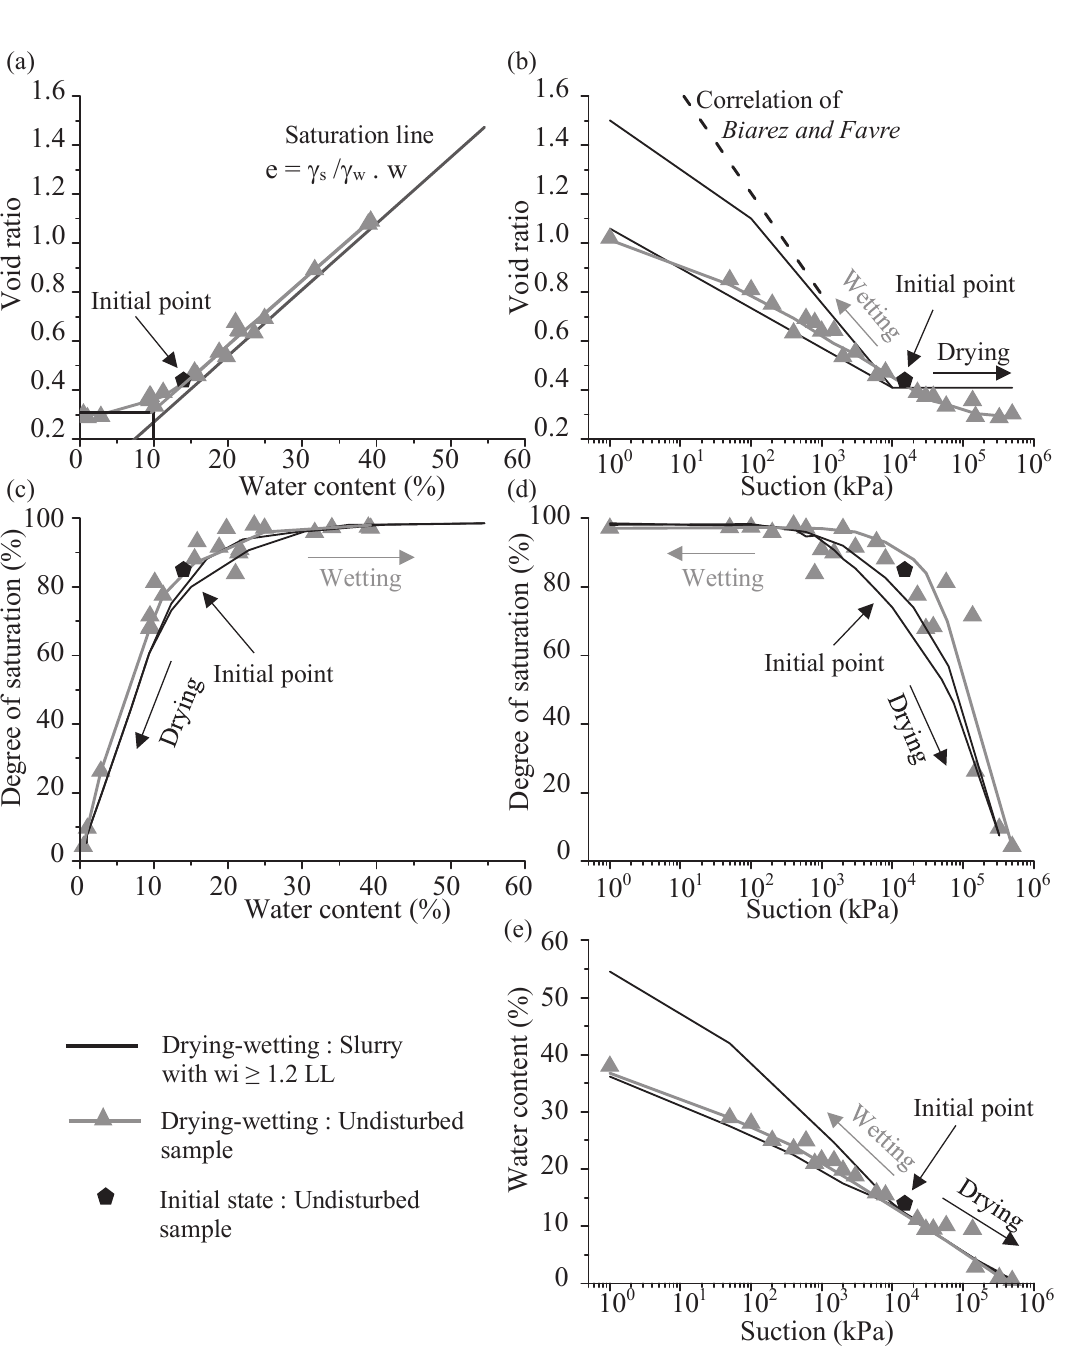
Figure 8: Drying-wetting path on the Boumagueur marl in his natural state (undisturbed